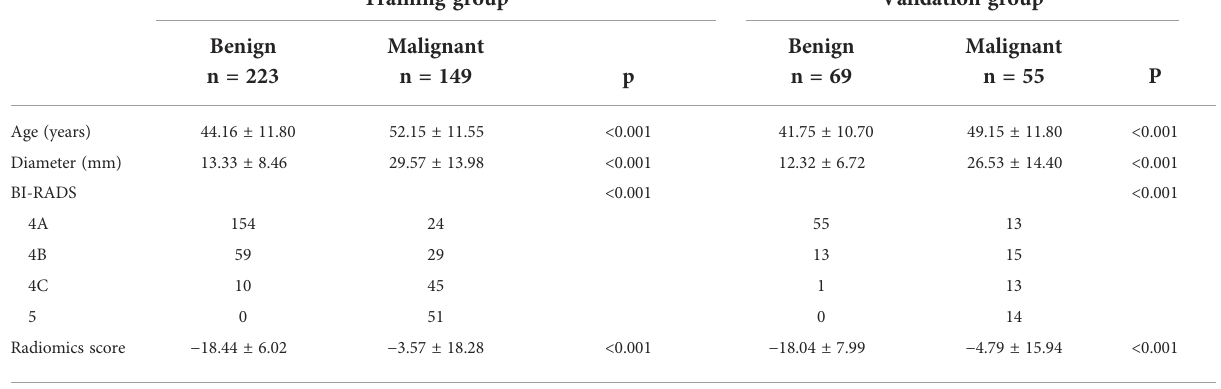
TABLE 1 Basic information in the training and validation groups.